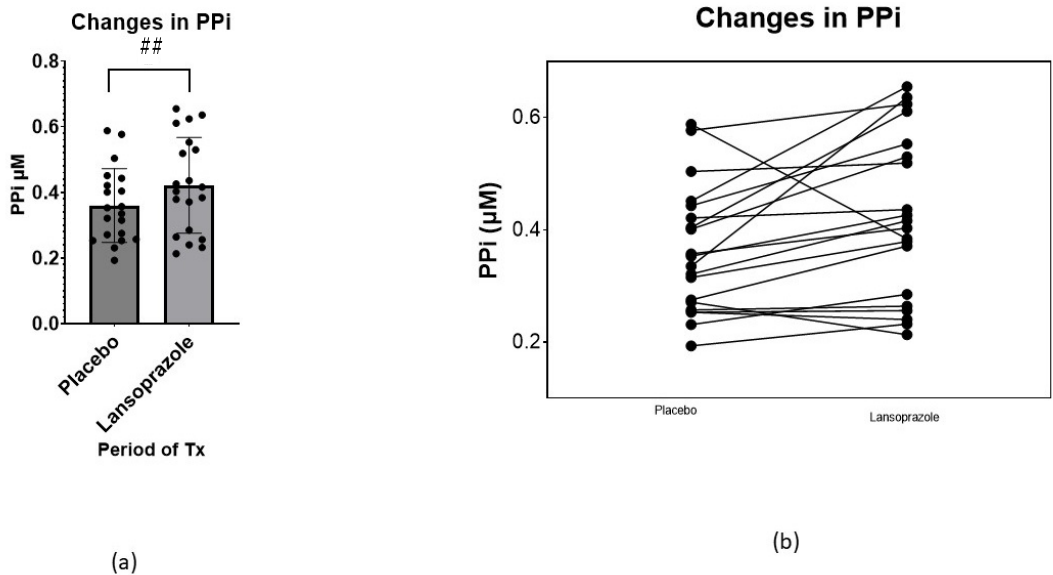
Figure 2. ( a ) Changes in plasma PPi comparing absolute changes at the end of the placebo phase and at the end of the lansoprazole phase (mean ± SD) ( p < 0.05). ( b ) Individual absolute changes in PPi, comparing the end of the placebo phase and the end of the lansoprazole phase. ## = p < 0.05.